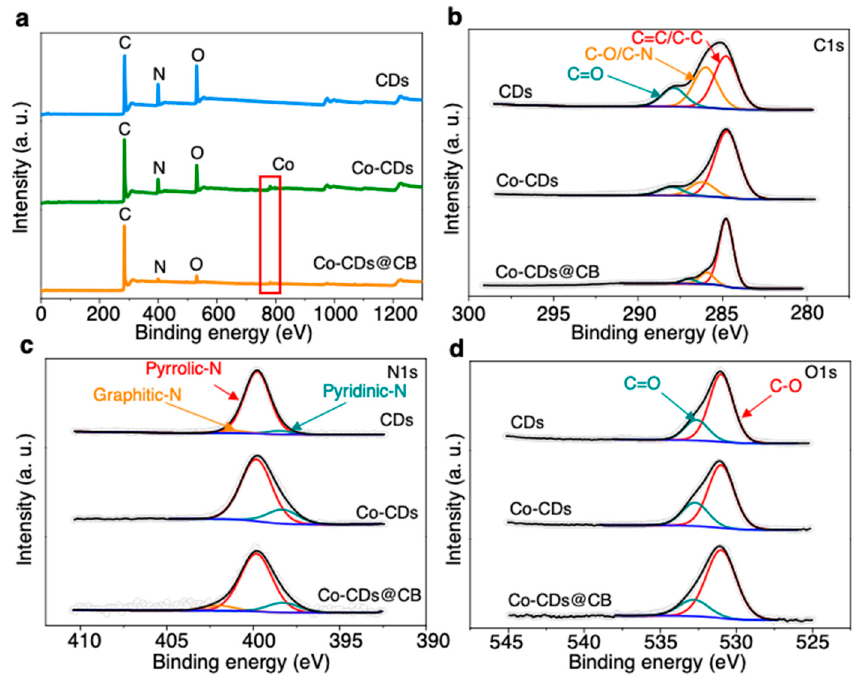
Figure 2. ( a ) XPS survey spectra of CDs, Co-CDs, and Co-CDs@CB. ( b ) High-resolution XPS C1s spectra of CDs, Co-CDs, and Co-CDs@CB. ( c ) High-resolution XPS N1s spectra of CDs, Co-CDs, and Co-CDs@CB. ( d ) High-resolution XPS O1s spectra of CDs, Co-CDs, and Co-CDs@CB.